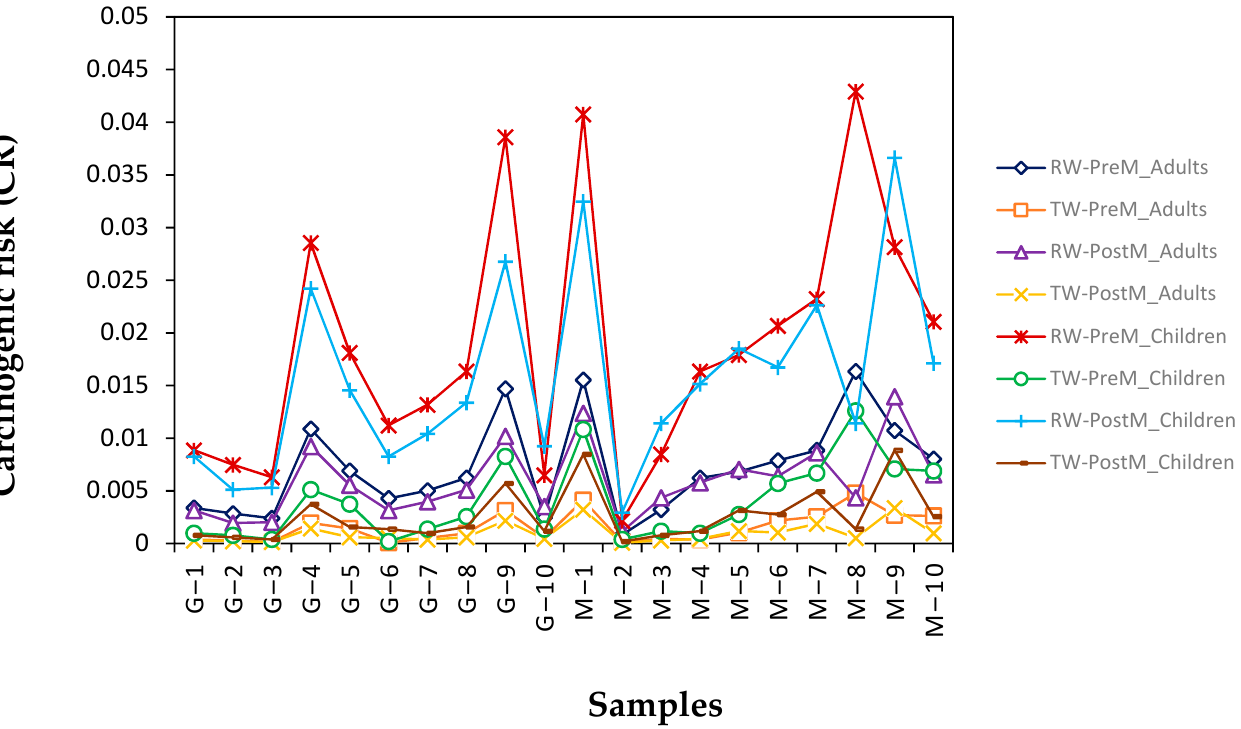
Figure 8. Carcinogenic risk (CR) of As in raw and treated water by AIRPs for adults and children during pre-monsoon and post-monsoon in rural areas of Bangladesh (RW-PreM, TW-PreM, RW-PostM, and TW-PostM refer to raw water pre-monsoon, treated water pre-monsoon, raw water post-monsoon, and treated water post-monsoon, respectively).